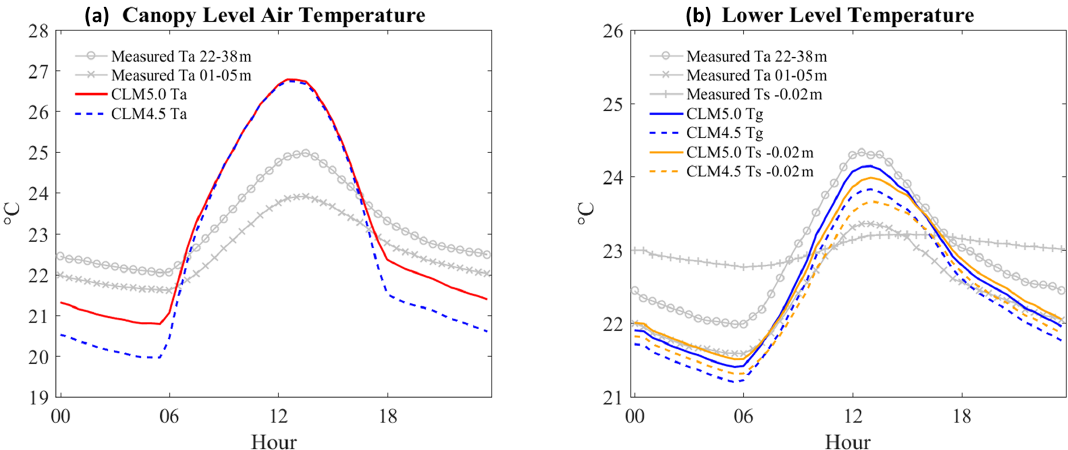
Figure 9. The ensemble diurnal variation of air temperatures. Canopy levels at 22–33 and 1–5m are measured air temperatures, T a represents air temperature at 28.075m in CLM, and T g is ground air temperature at 0.01m in CLM. T s − 0 . 02m is measured and simulated soil temperature. In (a) , both CLM4.5 and CLM5 overestimate in daytime ( + 0 . 8 and + 1 ◦ C) and underestimate during the nighttime ( − 1 . 9